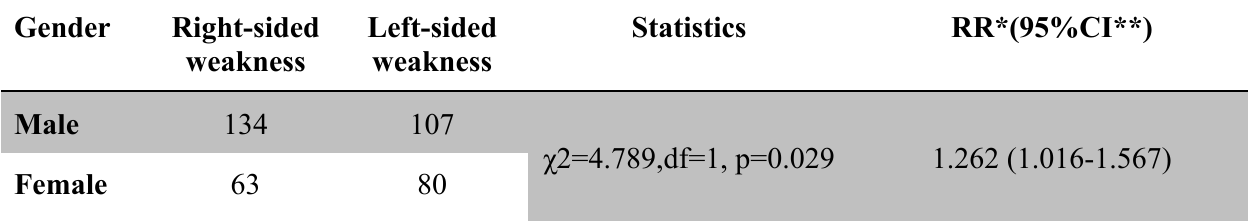
Table2: Association between gender and side of weakness.